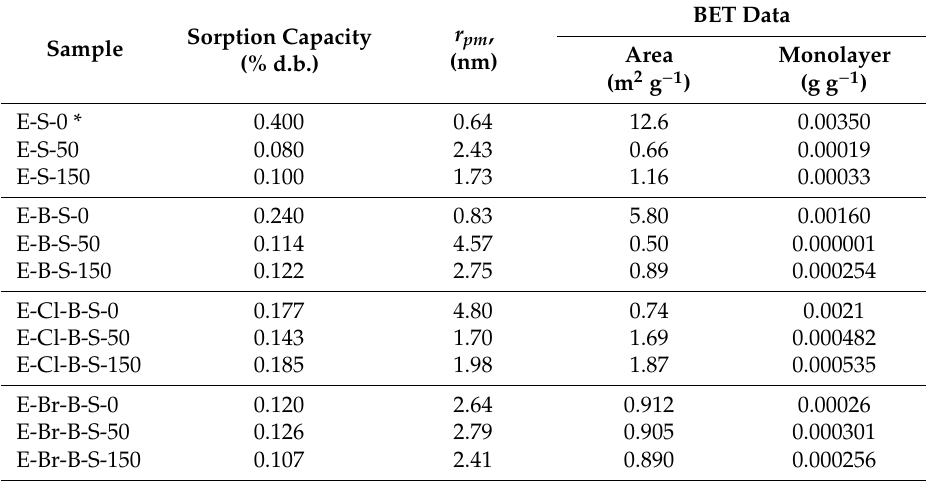
Table 7. Main data evaluated from sorption isotherms of tested